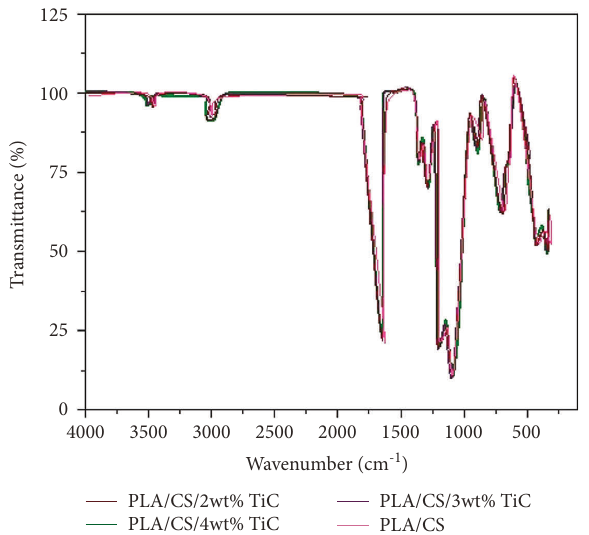
Figure 6: (a) Tensile strength, (b) tensile modulus, and (c) elon- gation at break of different